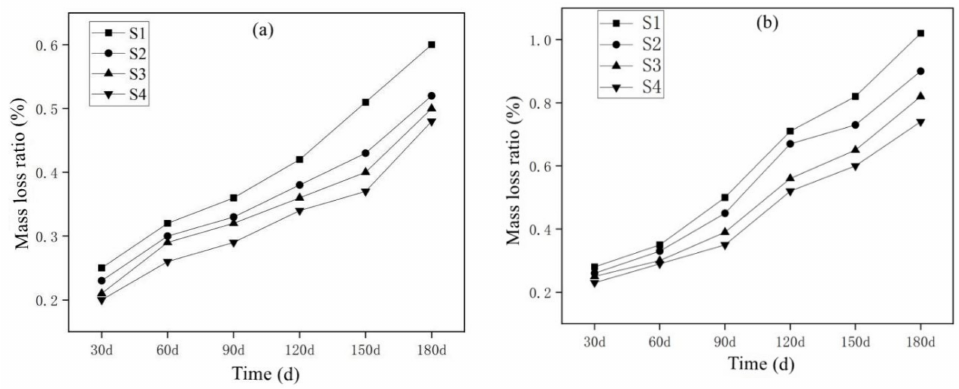
Figure 8. Mass loss rate of specimens soaked in water ( a ) and sodium sulfate solution ( b